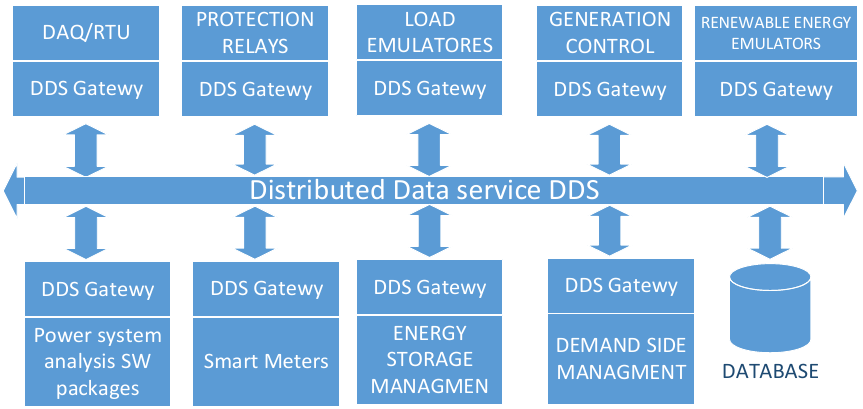
Figure 5. Smart grid testbed infrastructure. Table 1. Objects and topics list. Photovoltaic: PV.